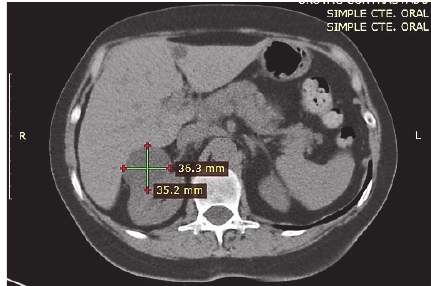
Figure 3: Photomicrograph histological section revealing multiple cysts and fibrous septa.